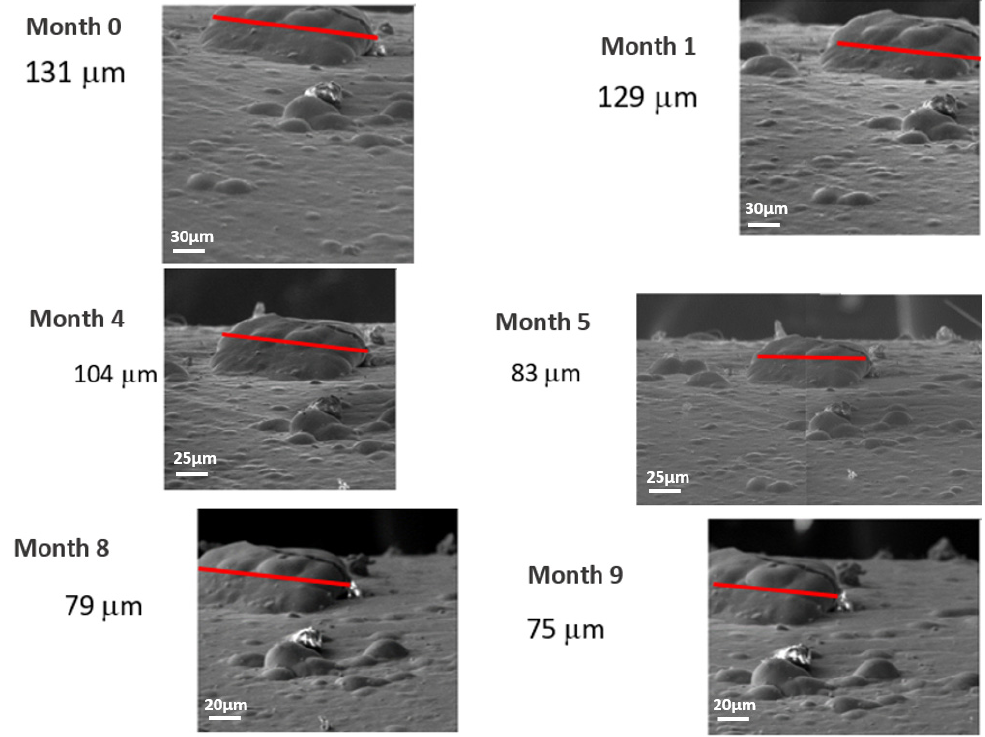
Figure 7. Example of evolution of a hillock in a white alkaline electrolyte sample without compressive stresses over time.